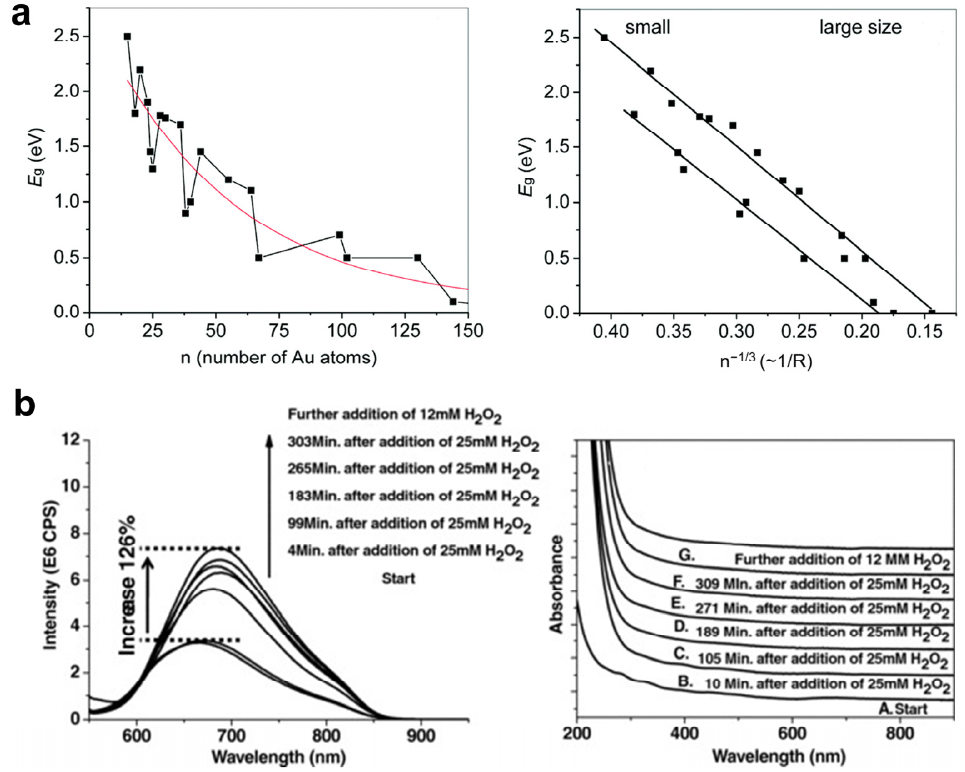
Figure 2. Metal core-related photoemission of MNCs. ( a ) Bandgap E g energies as a function of the size of Au n (SR) m NCs. Copyright (2015) Royal Society of Chemistry. ( b ) The oxidation process of Au 25 (SG) 18 by H 2 O 2 . Copyright (2012) Wiley-VCH.